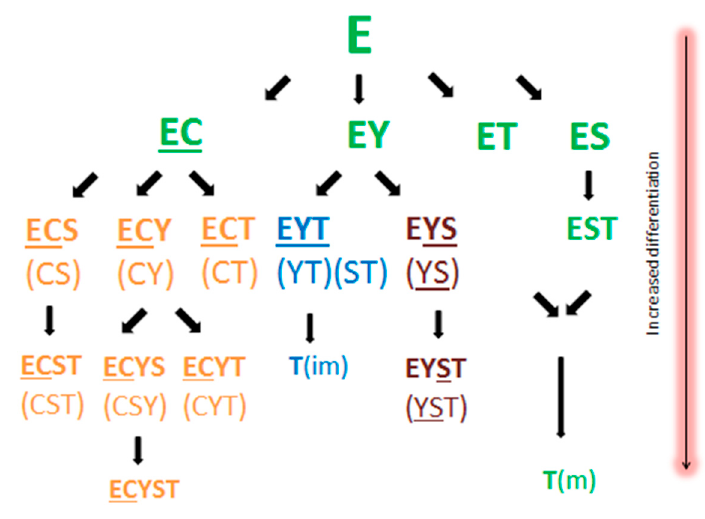
Figure 3. Subtypes of nonseminomatous mixed germ cell tumor of the testis. Courtesy of Cancer published by Wiley Periodicals, Inc. on behalf of American Cancer Society.